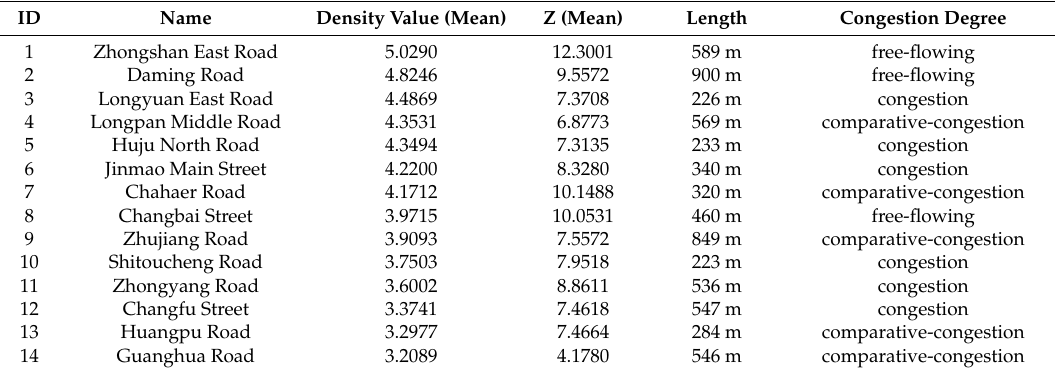
Table 4. The top 14 fire higher-risk location under road